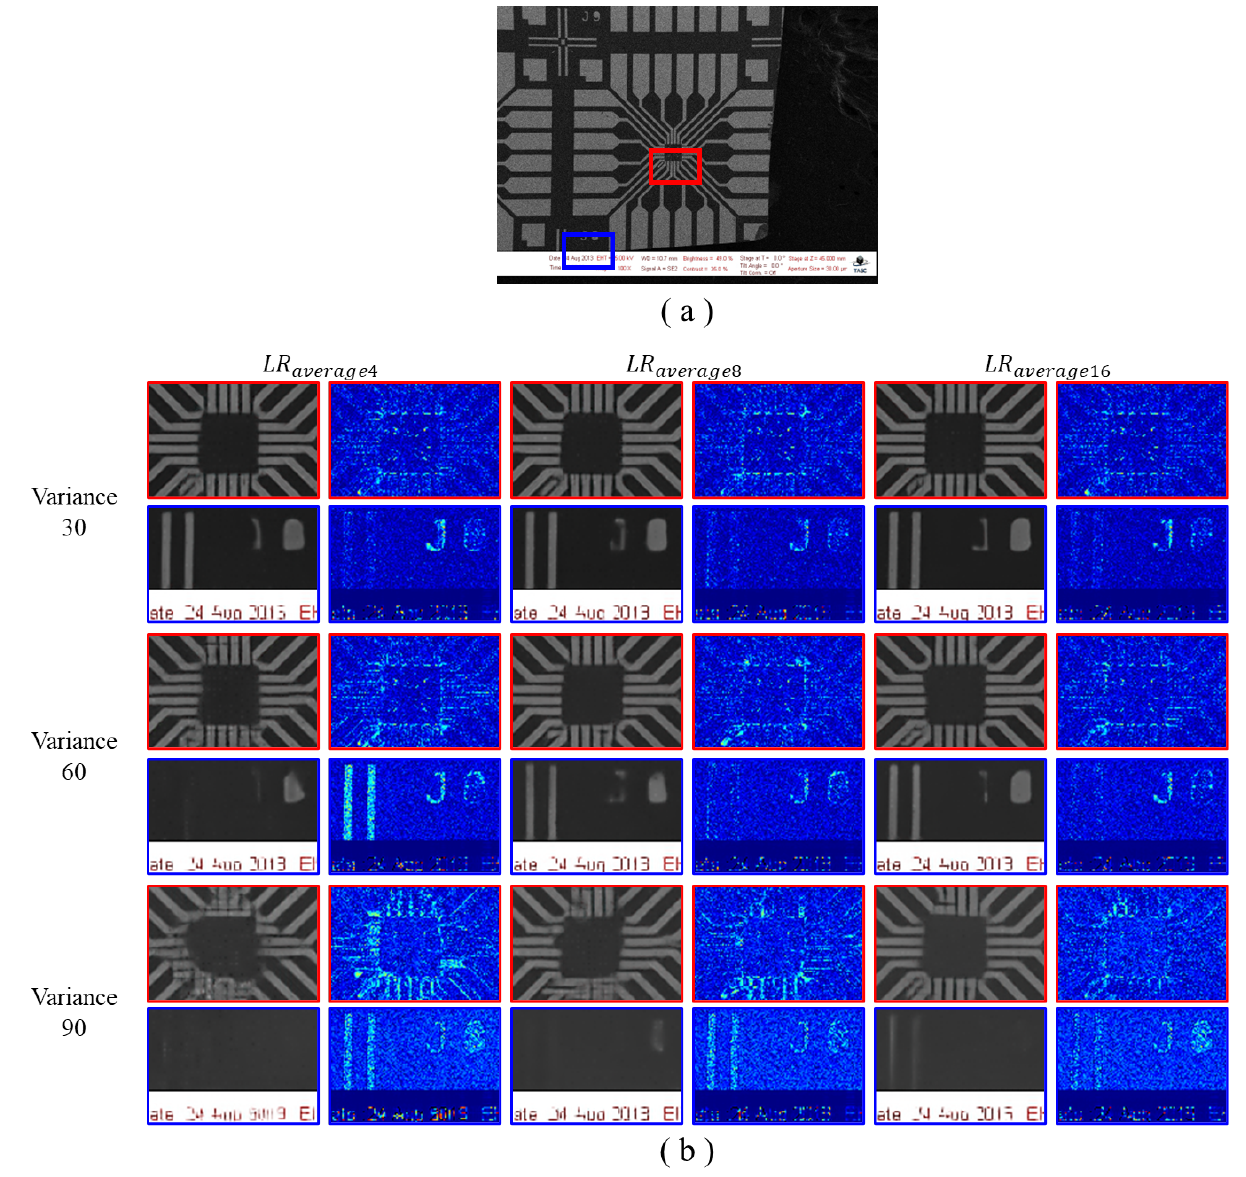
Figure 7. Qualitative comparison of our proposed scheme for different noise levels and different numbers of averaged images during denoising: ( a ) full-resolution image is the HR target image, which is given as a reference for the positions of the magnified boxes; ( b ) the magnified images and error map are illustrated in the heat map for reference ( a ). Images are evaluated for different noise levels (variances of 30, 60, and 90) and different numbers of averaged images for denoising (4, 8, and 16 images used). The red and blue boxes show the magnified SR results and the error map trained for each setting for LR average images at each noise level, respectively. The error map is illustrated as a heat map, with the error between the SR and target HR images amplified five times for visual comparison. The baseline network chosen is